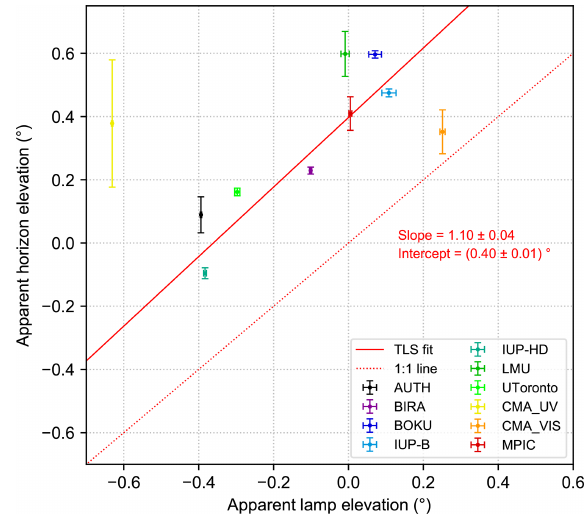
Figure 20. Correlation between retrieved horizon (at 440nm) and lamp elevations for all participating instruments that reported results for both methods. The error bars indicate the standard errors of the mean lamp and horizon elevations. Further, the result of a total least square (TLS) fit and the 1 : 1 line are